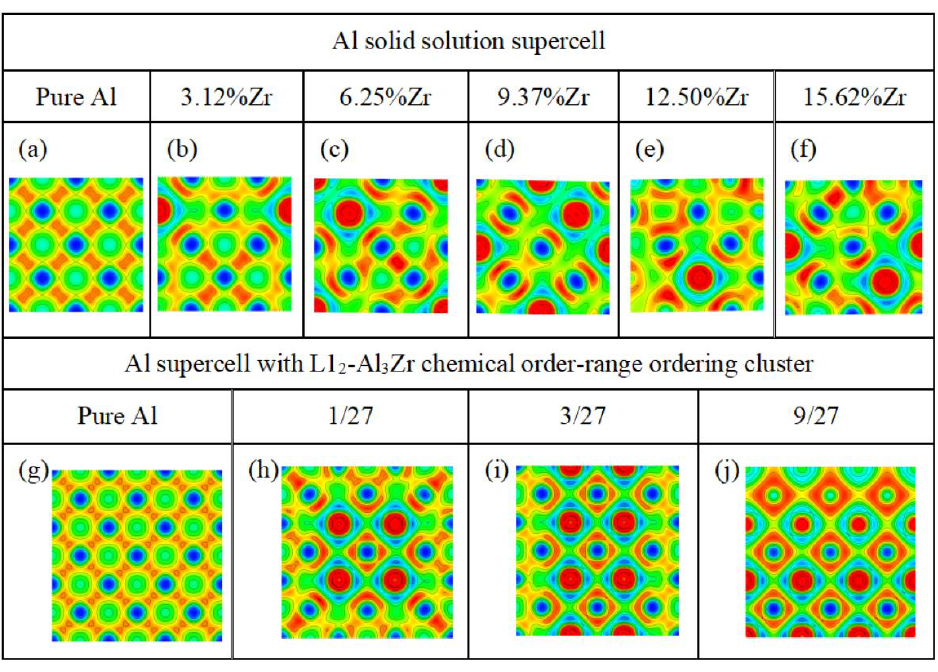
Figure 8. ( a – f ) Electron localization function (ELF) of pure Al and Al solid solution with varied compositions of the solute atoms Zr after relaxing atoms and volumes and ( g – j ) electron localization function (ELF) of pure Al and Al supercells with the chemical short-range ordering clusters L1 2 -Al 3 Zr after relaxing atoms and volumes. The isosurface value is set to 0.7 e/Bohr 3 . 3.5. The Projected Density of State (PDOS)